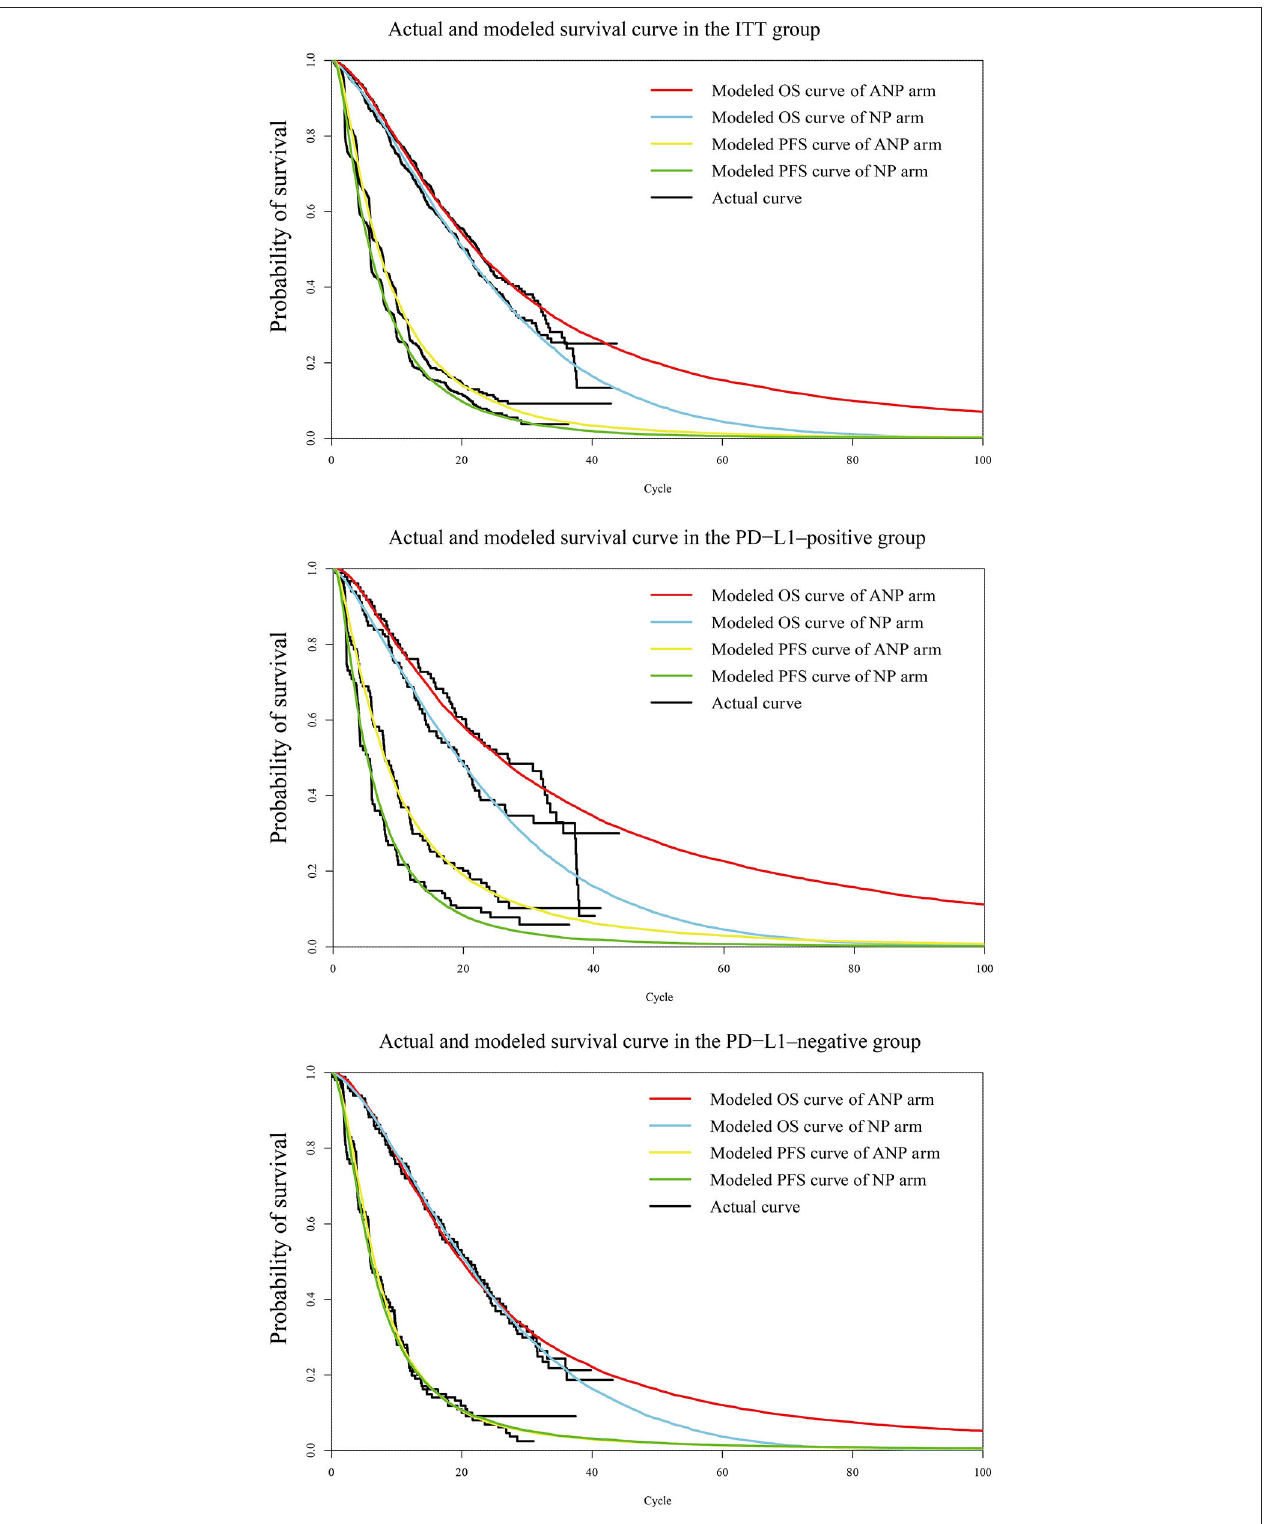
FIGURE 2 | Diagram of modeled PFS and OS fit curves in different regimens. The colored lines represent the modeled survival curves, the black lines represent the actual survival curves. Each cycle of the x-axis is 4 weeks. PFS, progression-free survival; OS, overall survival; ITT, intention-to-treat; PD-L1, programmed death ligand-1. ANP, atezolizumab plus nab-paclitaxel; NP, nab-paclitaxel.